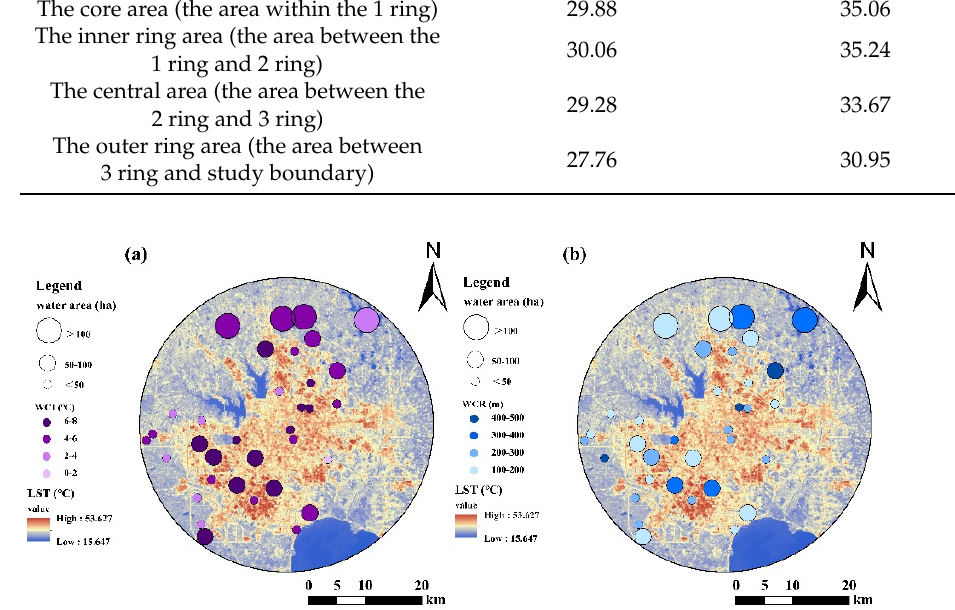
Figure 7. ( a ) WCI of 34 selected water bodies; ( b ) WCR of 34 selected water bodies.